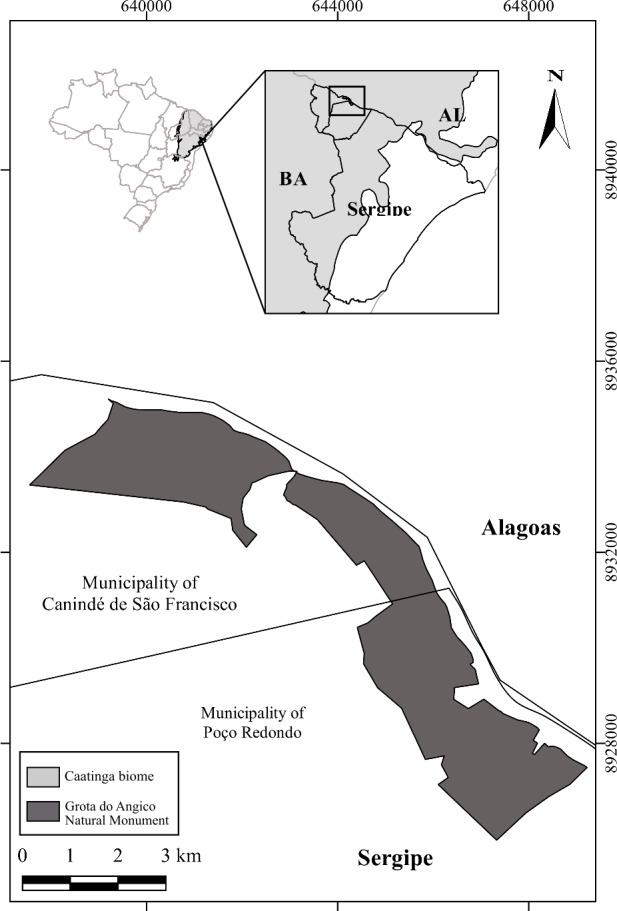
The study area.Monumento Natural Grota do Angico—MNGA (dark gray), and the occurrence of the Caatinga Biome (light gray). The MNGA covers approximately 2,183 ha and is located between the municipalities of Poço Redondo and Canindé de São Francisco, northeastern Brazil. Map created in QGis 2.14 Essen (http://www.fsf.org/).